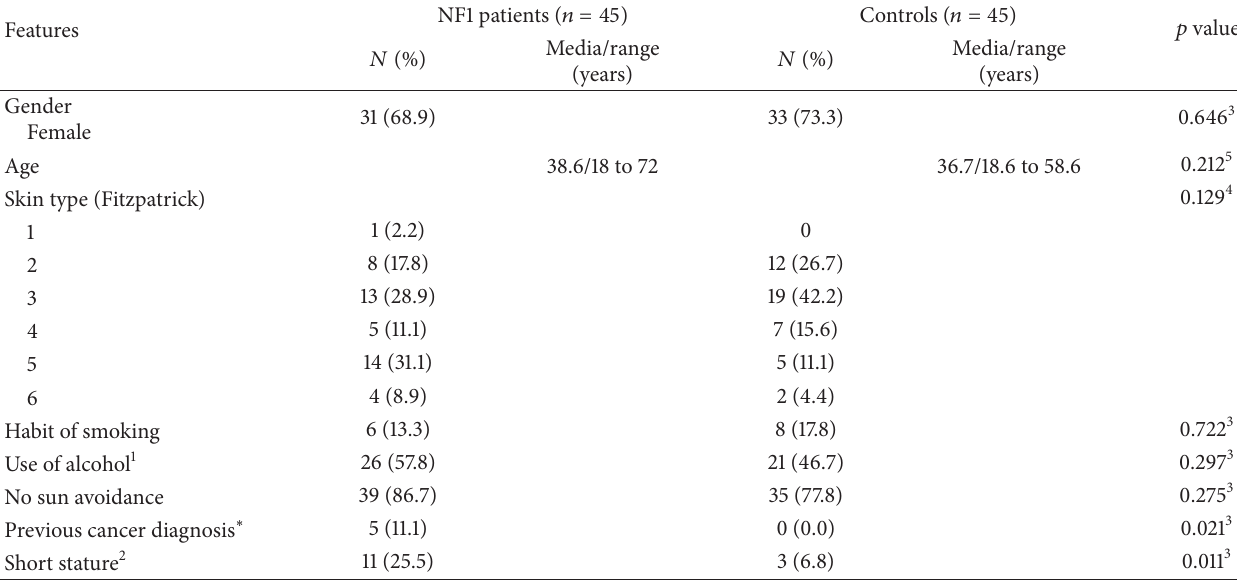
Table 1: Clinical and demographic features of NF1 patients and controls included in the study.